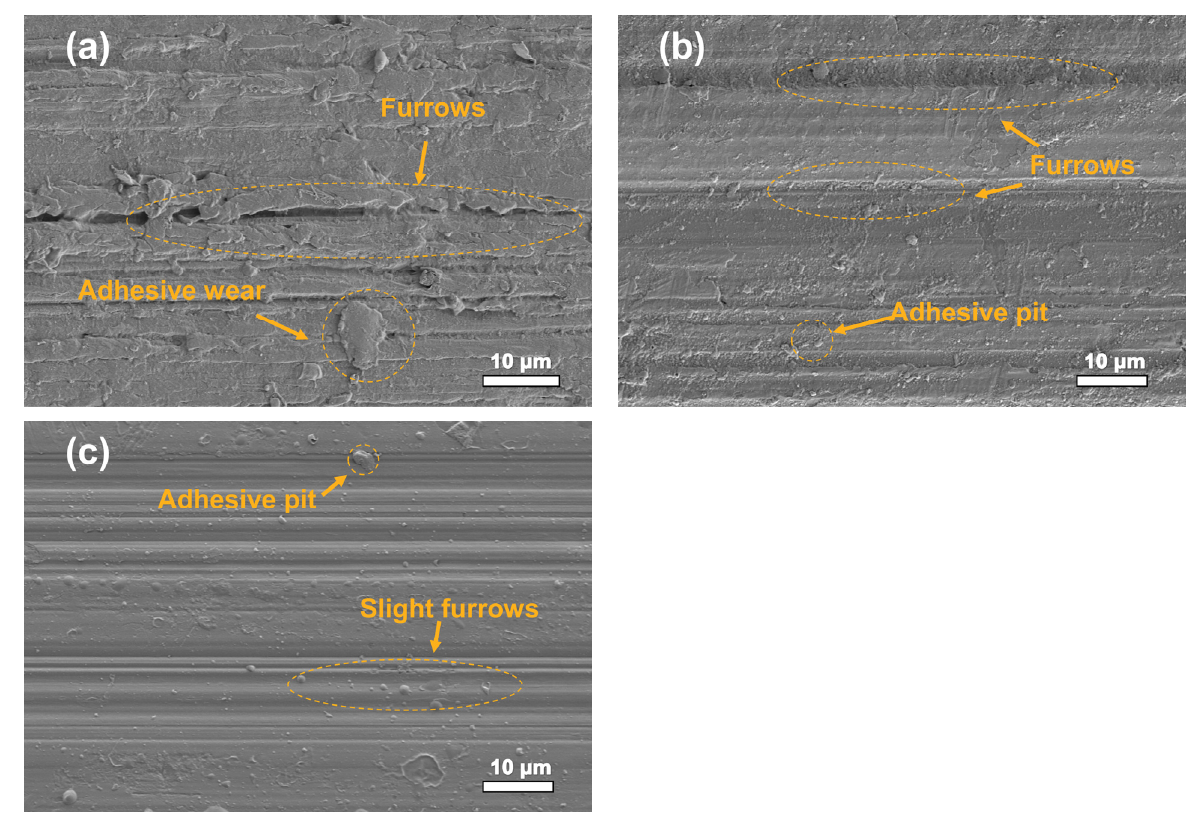
Figure 7. The SEM micrographs of the worn surfaces of different composites: ( a ) pure PEEK; ( b ) PEEK/10 wt% PTFE; ( c ) PEEK/10 wt% PTFE/0.5 wt% BP. (EHT = 3.00 kV, Mag = 1600 × ).